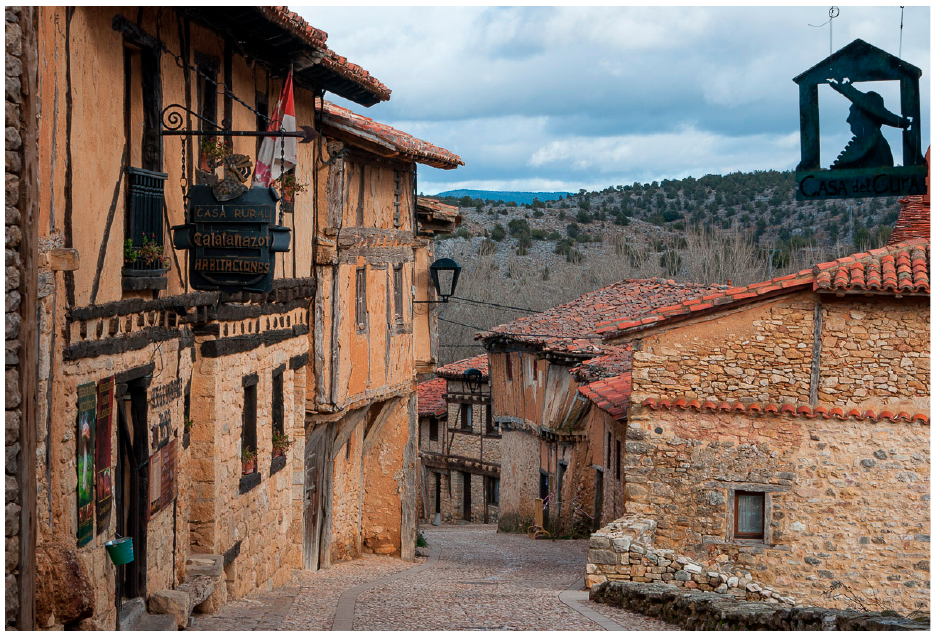
Figure 1. Vernacular houses in Calatañazor, Central